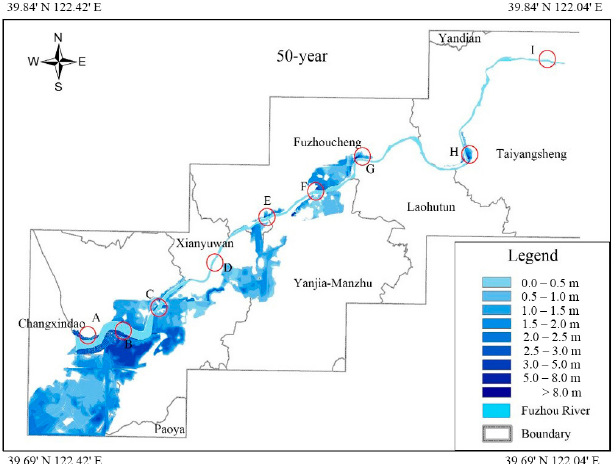
Figure 10. Flood arrival time and submerged area of 50-year return period scenario.